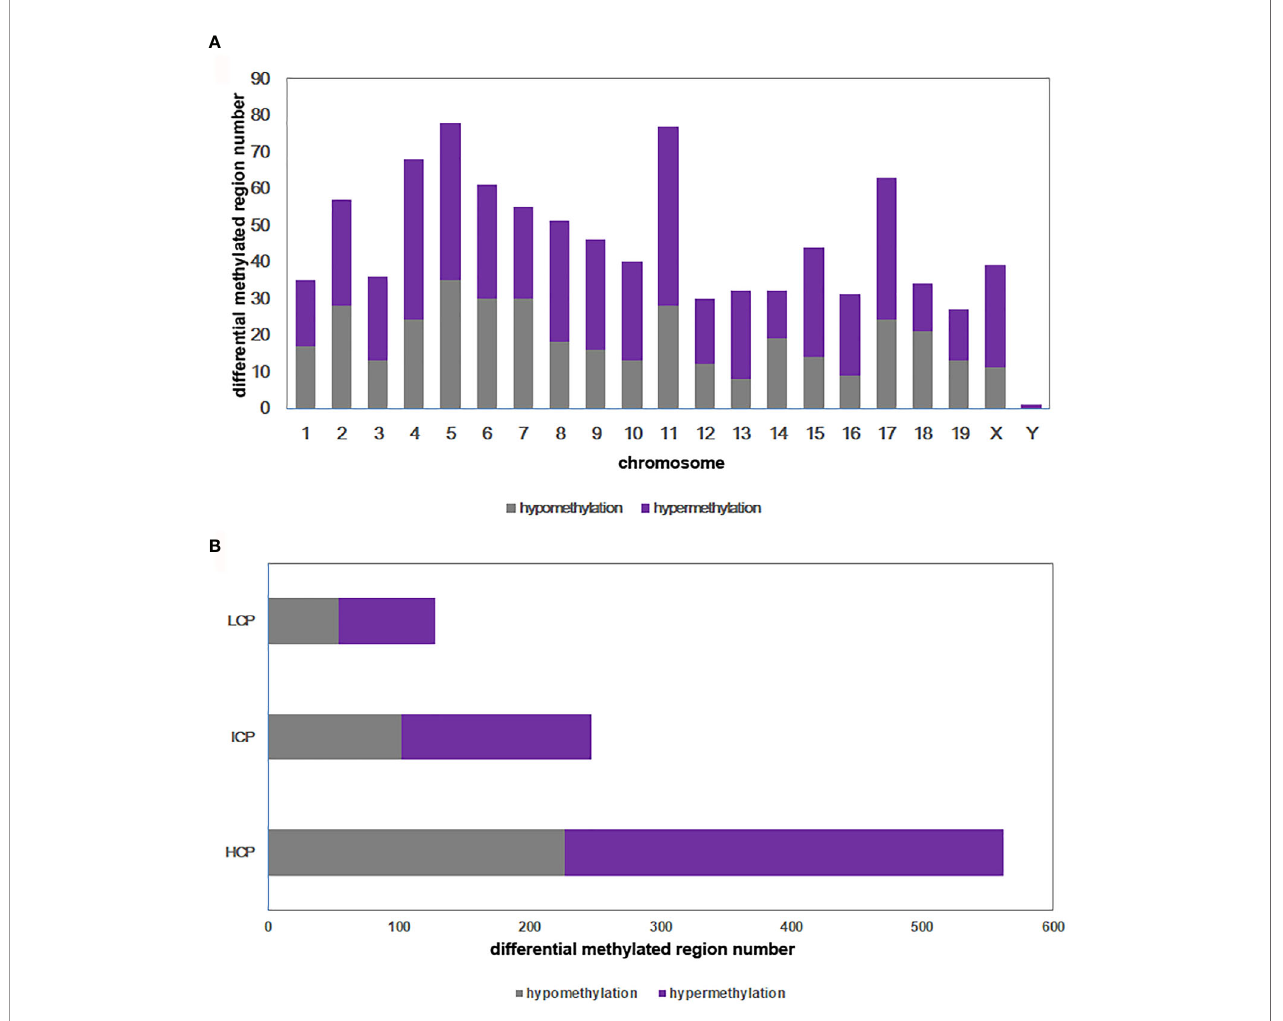
FIGURE 5 | Differential methylated regions between DIO-CD group and NC-CD group. (A) Chromosomal distribution of differentially methylated regions. (B) CpG density of differentially methylated regions. Classi fi cation of all regions with high (HCP), intermediated (ICP), and low (LCP) CpG content.